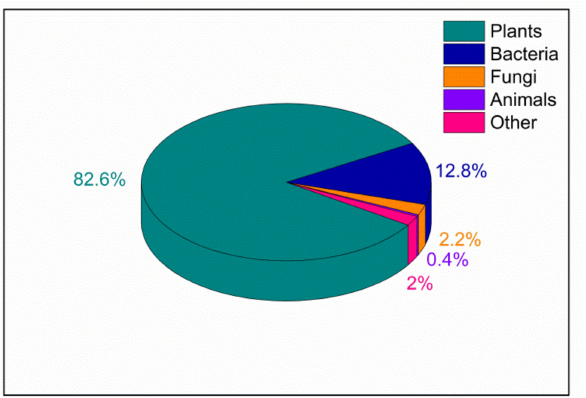
Figure 1. Biomass distribution for abundant taxonomic groups according to Bar-on et al. [18]; the category labelled as “Other” includes Archaea, Protists and